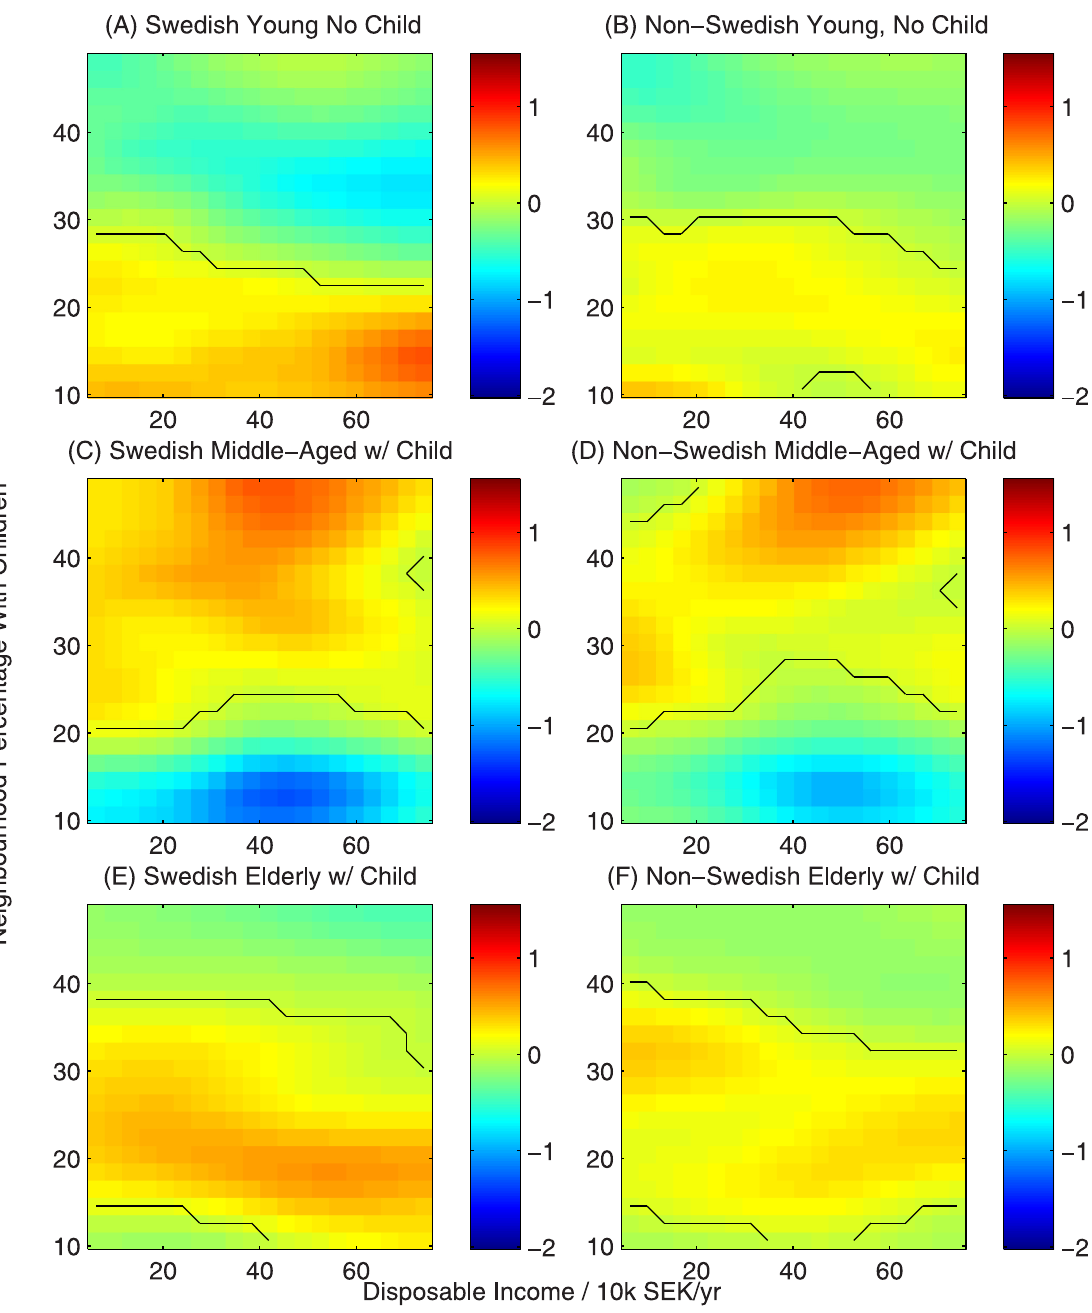
Fig 5. Utility function for neighbourhood percentage of residents with children. Black contours represent a utility of zero, indicating no overall preference for or against neighbourhoods with this characteristic.